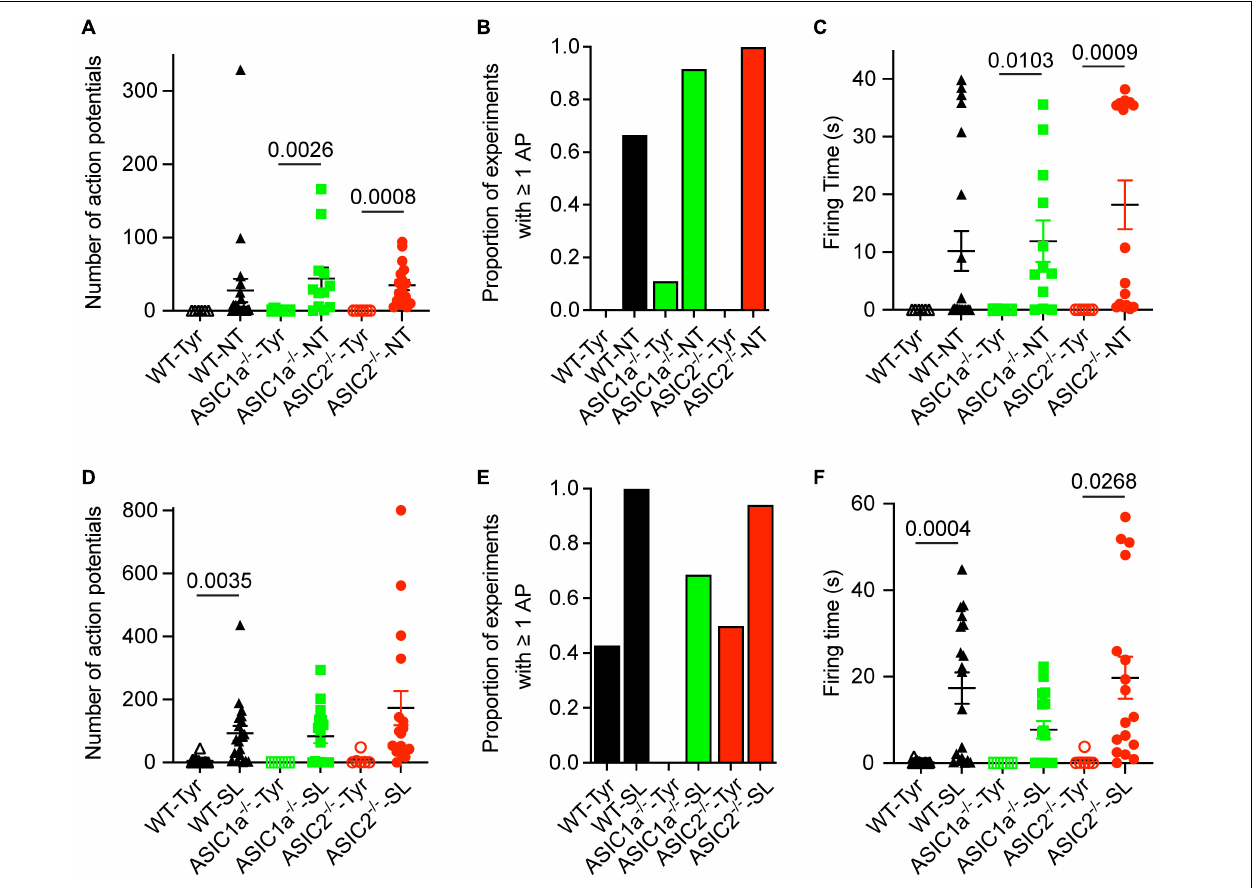
FIGURE 3 | Analysis of AP number and firing time as a function of genotype and ion composition. The data were obtained from current-clamp experiments with cortical neurons as described in the legend to Figure 2 . (A,D) Number of APs induced by solution changes from Tyr-pH7.4 to the solutions indicated, at pH7.0 (A) or pH6.8 (D) , in WT, ASIC1a − / − and ASIC2 − / − cortical neurons ( n = 6–21). (B,E) The proportion of experiments in which at least 1 AP was induced is indicated for the different conditions and genotypes, Tyr and NT solution at pH7.0 in (B) and Tyr and SL solution at pH6.8 in (E) , n = 6–21. (C,F) FT, determined as described in the legend to Figure 2 , for the indicated experimental conditions [ (C) pH7.0, (F) pH6.8], n = 6–21. For this analysis, the data solution changes with different kinetics were pooled, since the pH ramp kinetics did not influence the AP induction ( Figure 2 ). The statistical significance of the differences between mean values was tested with the Kruskal-Wallis test, followed by Dunn’s multiple comparisons